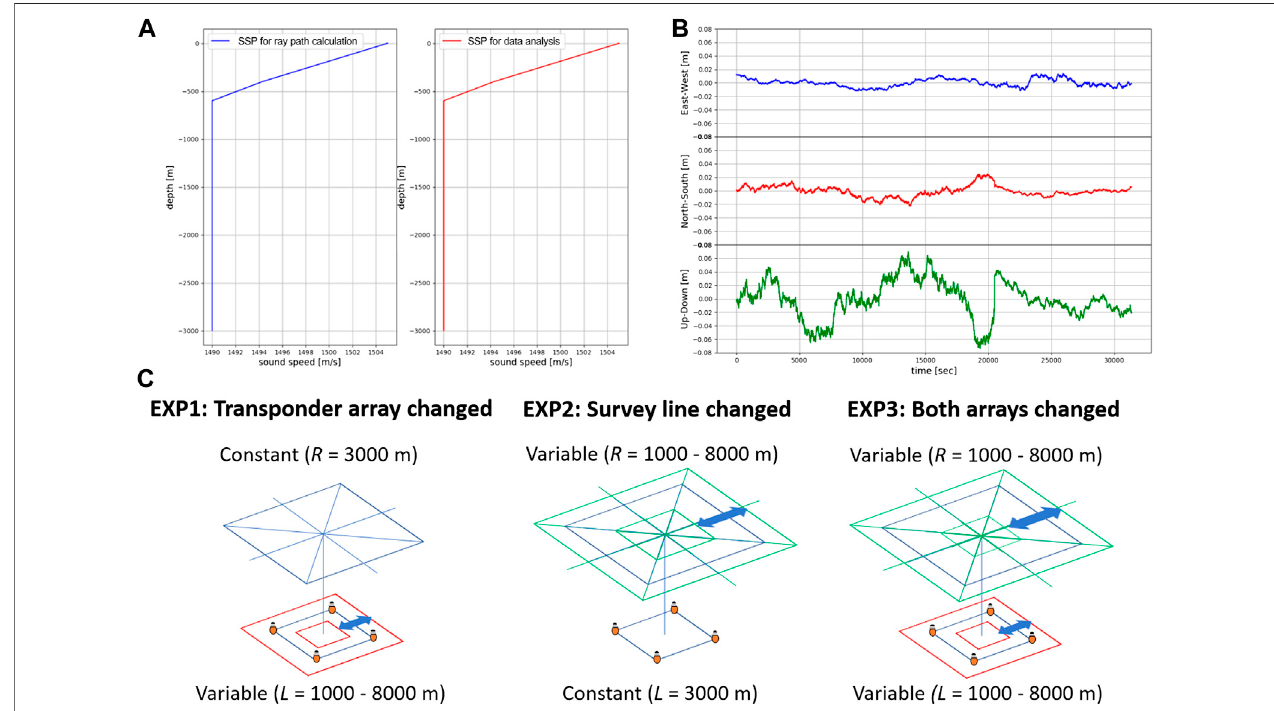
FIGURE 3 | The con fi gurations of our numerical experiment. (A) shows the vertical sound speed pro fi le (SSP) con fi gured for the ray path calculation (left, blue line) andtheverticalSSPusedinthedataanalysis(right,redline).Notethatthedifferencebetweenthesetwopro fi lesissosmallthatthedifferencecannotbedistinguishedin this fi gure (see Con fi gurations of the Numerical Experiments for details). (B) indicates sample waveforms of the GNSS pseudo-random walk added to the synthesized data (from top to bottom, the east-west, north-south, and up-down components). (C) isthe schematic diagram of the settings of EXP1, EXP2, and EXP3, from left to right (see Con fi gurations of the Numerical Experiments for